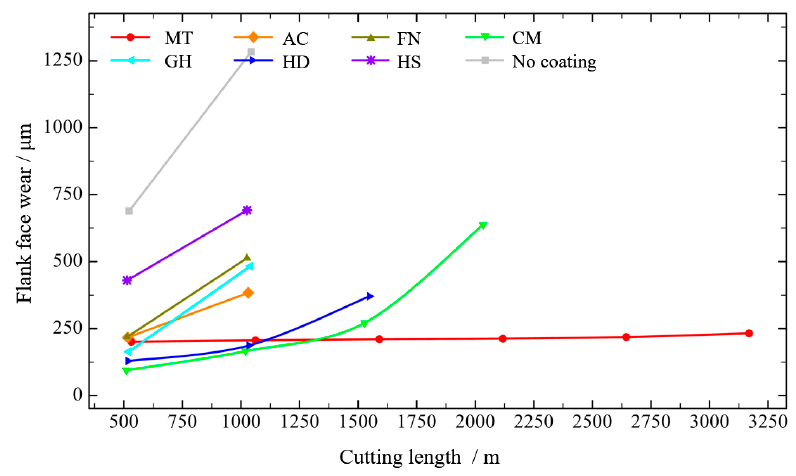
Figure 17. Tool flank wear of different coatings at high speed.